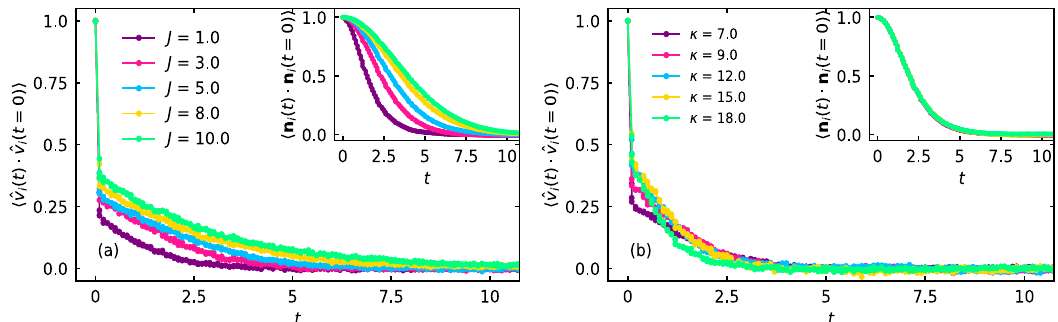
v v 0 ) Figure 7. ( a ) Velocity auto-correlation for various values of J , shown in the legend, for fixed i ( t ) · ˆ i ( t = �ˆ � = 125 . Inset shows the auto-correlation of propulsion direction n n 7 , M 0.05 , and P 0 ) κ e i ( t ) · i ( t = = = � � v v 0 ) for the same set of J and the other parameters considered in ( a ). ( b ) for several values of the i ( t ) · ˆ i ( t = �ˆ � n n 2 . Inset shows 0 ) softness parameter κ , shown in the legend, for fixed J for the same value of κ i ( t ) · i ( t = = � � in (b). Other parameters are same as in ( a Green and yellow curves correspond to the particles in the central and the peripheral region, respectively, as shown in Fig. 5b,e. In the central region, the local speed becomes small for the soft disks, as the local area frac- 7 in the peripheral region is sufficiently large, the tion becomes large. As the local speed for the soft disks at κ = particles in the peripheral region mix throughout the system. Hence, the retention fraction of the soft disks in the peripheral region (yellow curve in Fig. 6a) saturate quickly. However, due to their softness, the peripheral disks t 1 steadily move towards the center of (yellow disks) and the disks in the low density phase (purple disks) at t = t 1 (green disks) steadily shuttle the high density region. Consequently, the soft disks of the central region at t = out of it, to maintain the constant area fraction in the central region. Hence, a finite slope is found for the green 7 ). At much larger time t t 1 30 for the soft disks ( κ t 1 > 30 , it saturates. Time t 1 ) at t curve of R ( t = = + − − 7 ) is shown in Supplementary Movie 1. On the other hand, due to extremely evolution for the soft disks ( κ = small deformation and negligible speed of the hard disks ( κ 17 saturates t 1 ) corresponding to the peripheral disks at κ = − t 1 ) 0 ). Peripheral disks (yellow colored disks) rejoin the high density phase quickly at small value ( R ( t − → through the other side, due to periodic boundaries. A finite fraction of disks still penetrate inside the central